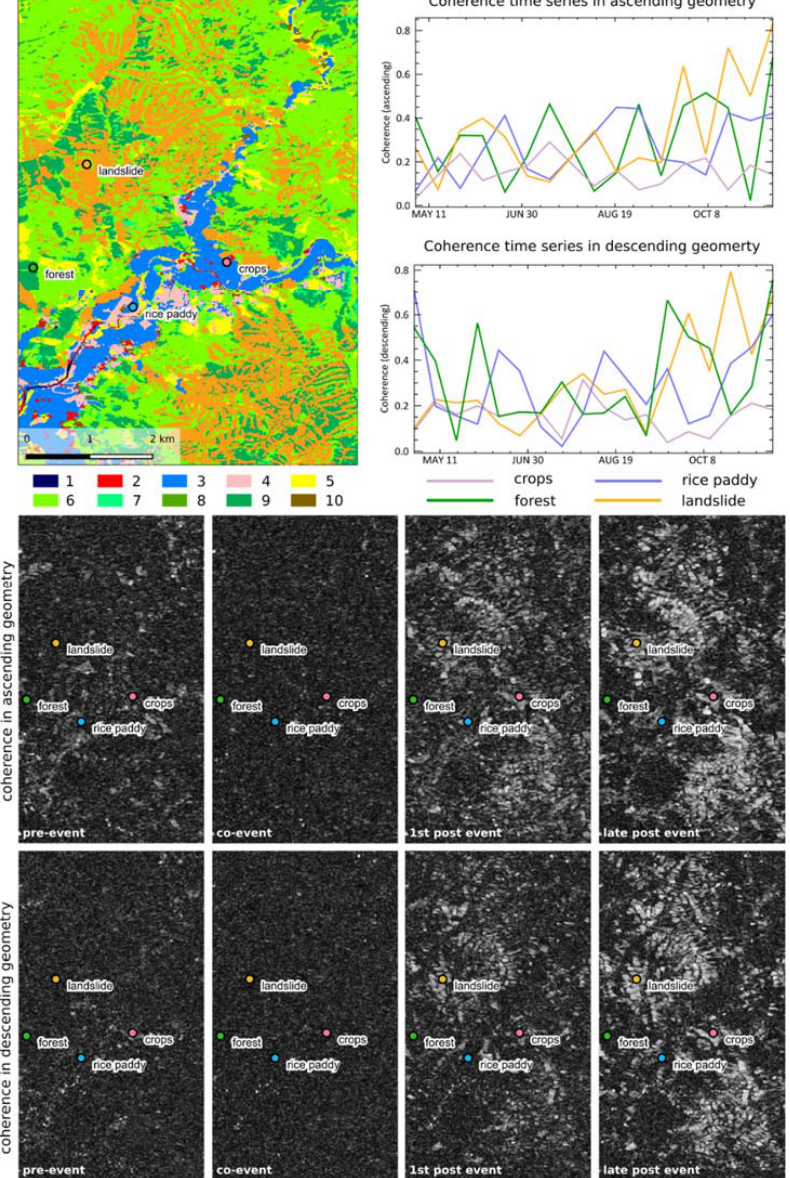
Figure 9. Temporal change of the coherence in ascending and descending geometries. Legend: 1 = water; 2 = urban and built ‐ up; 3 = rice paddy; 4 = crops; 5 = grassland; 6 = deciduous broadleaf forest; 7 = deciduous needle ‐ leaf forest; 8 = evergreen broadleaf forest; 9 = evergreen needle ‐ leaf forest; 10